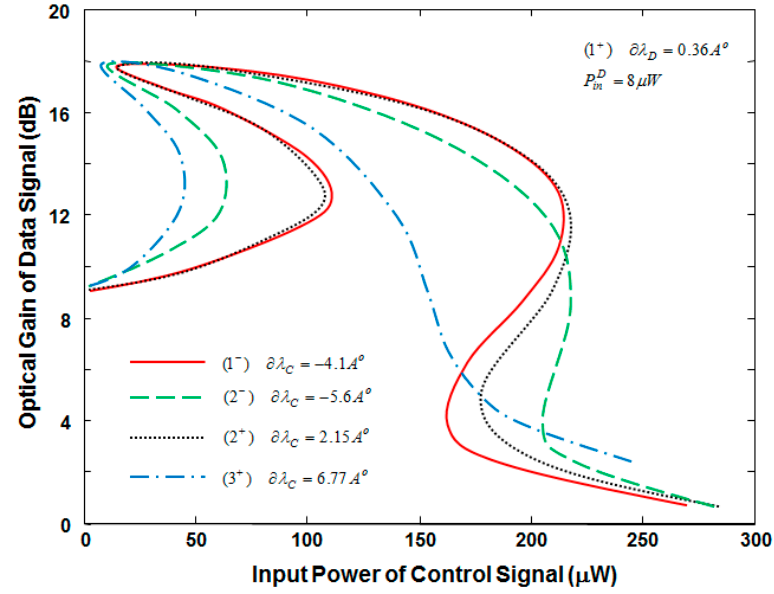
Figure 6. Optical gain of data signal as a function of control-signal input power when the control-signal wavelength is tuned to different comb modes.